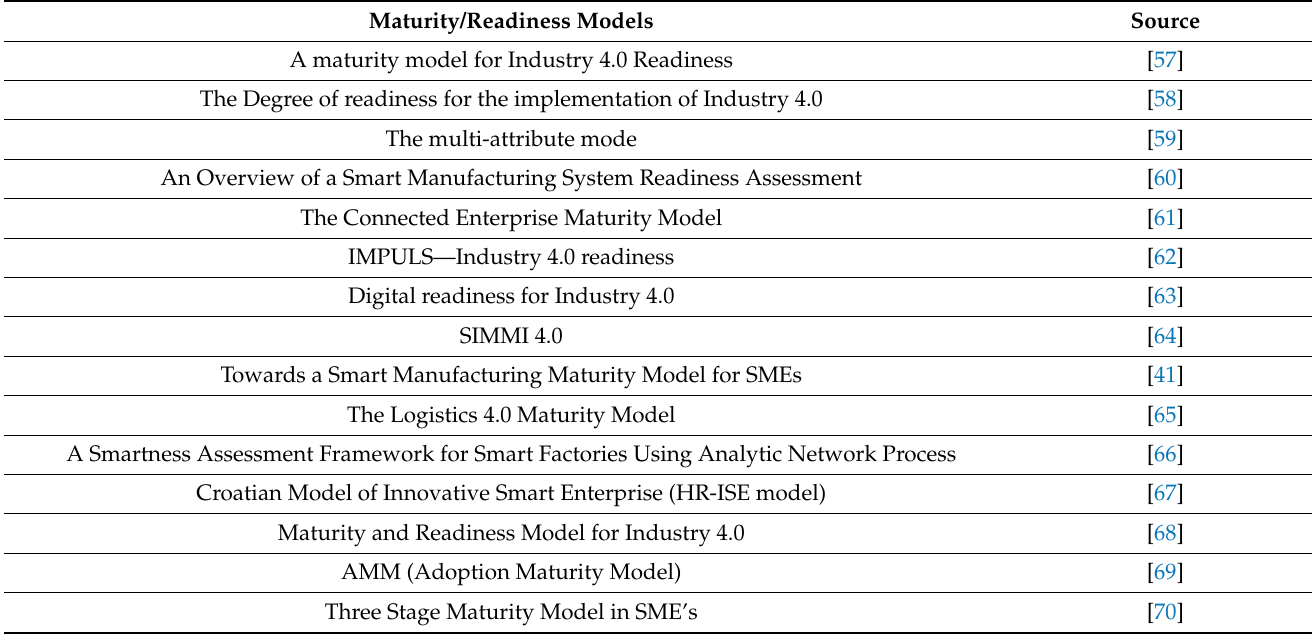
Table 1. Summary of models to determine the digital maturity of enterprises. Maturity/Readiness Models Source A maturity model for Industry 4.0 Readiness [57] The Degree of readiness for the implementation of Industry